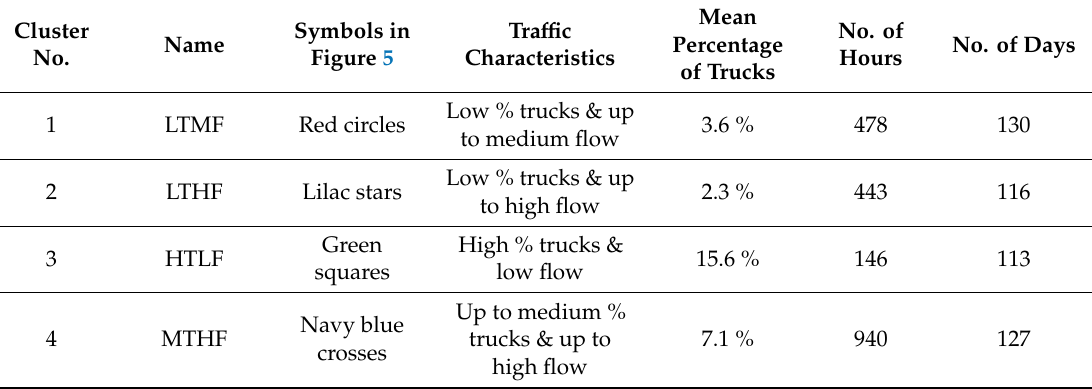
Table 1. Clusters